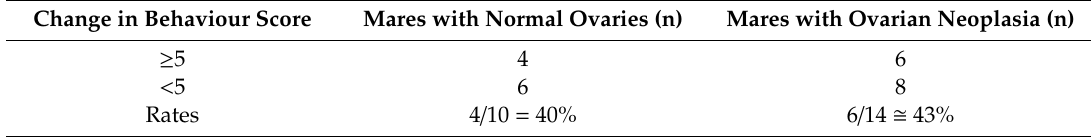
Table 4. Change in behaviour score after bilateral ovariectomy in mares with and without ovarian neoplasia. A change in score of ≥ 5 was considered a marked positive change in behaviour following ovariectomy. Four horses were excluded due to no histologic